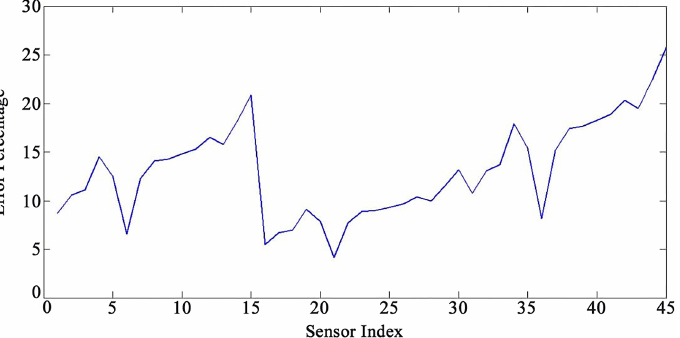
Figure 9. Error percentage for each sensor under loading number 3 (45-degree attack